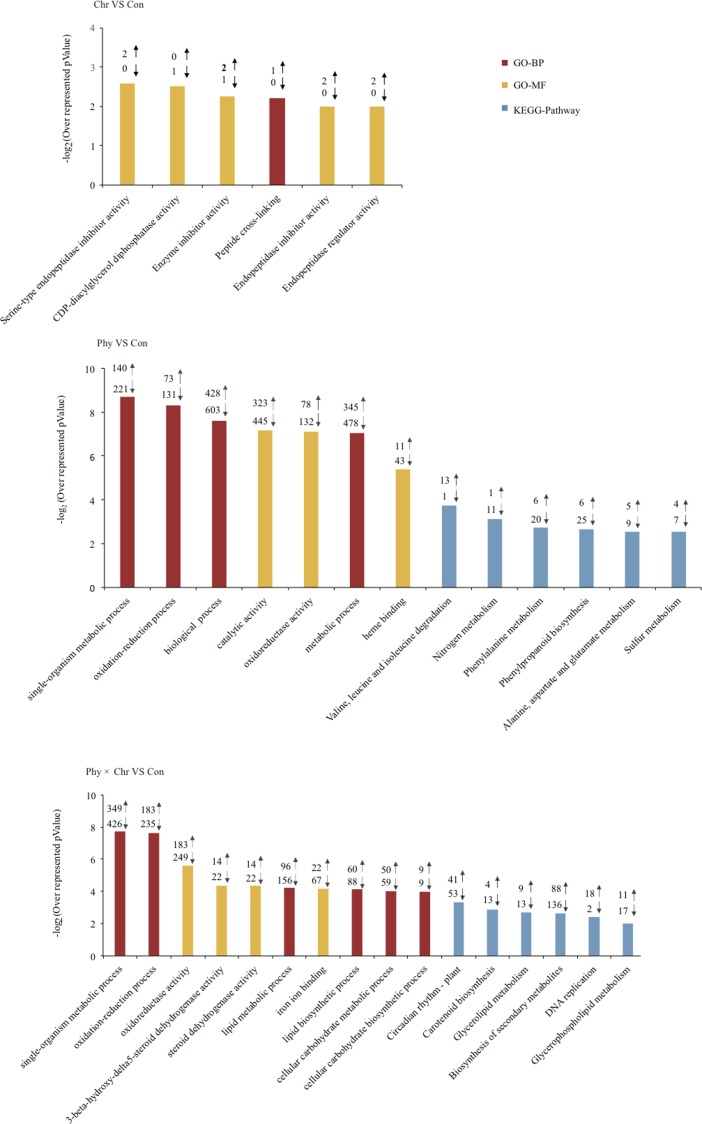
Top 10 Go (gene ontology) and pathway categories enriched for up- (up arrows) and down-regulated (down arrows) genes differentially expressed in cucumber leaves activated by chrysophanol and/or physcion.The p value, indicating the significance of the comparison, was calculated using a Benjamini-corrected modified Fisher’s exact test. BP, biological process; MF, molecular function.